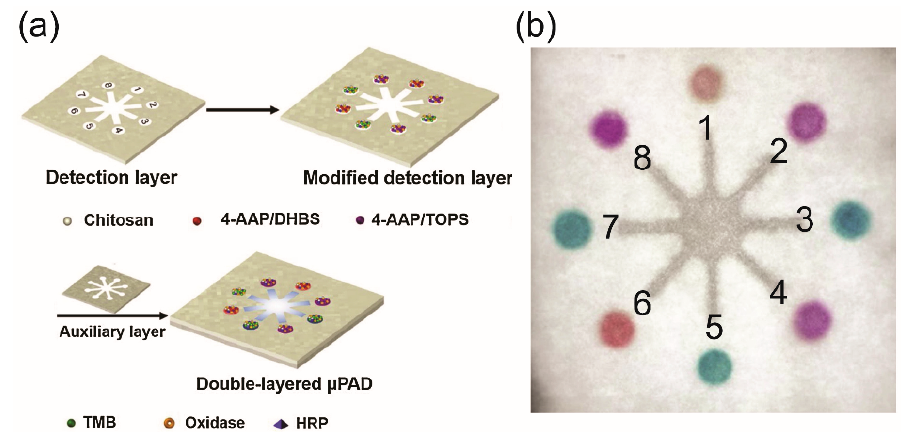
Figure 5. ( a ) Schematic illustration of the device structure, ( b ) color photograph of a µPAD after colorimetric detections of glucose (1, 2), uric acid ((3, 4), choline (5, 6), and lactate (7, 8). Reproduced with permission from the authors [125]. Copyright 2019, Elsevier B.V.